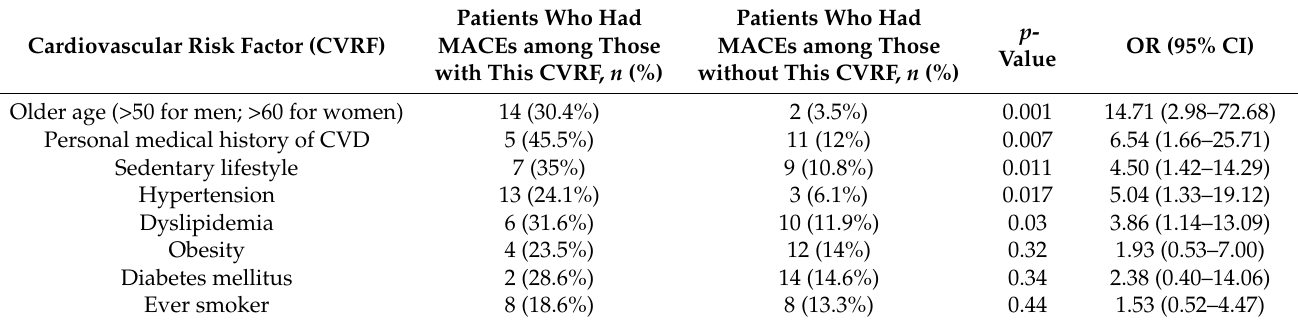
Table 3. Impact of each cardiovascular risk factor on the occurrence of major cardiovascular events during follow-up in ANCA-associated vasculitis patients from the OSTEOVAS cohort. The multivariate analysis was adjusted for the use of glucocorticoids and